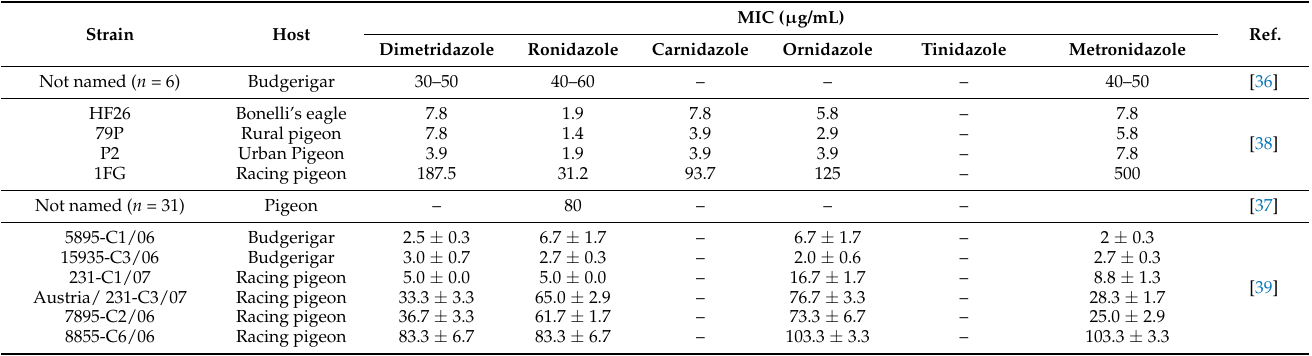
Table 3. Minimum Inhibitory Concentration (MIC) in µ g/mL of different nitroimidazole drugs evaluated against trichomonads isolated from avian oropharynx. The name of the strains and the host of which isolates were obtained are